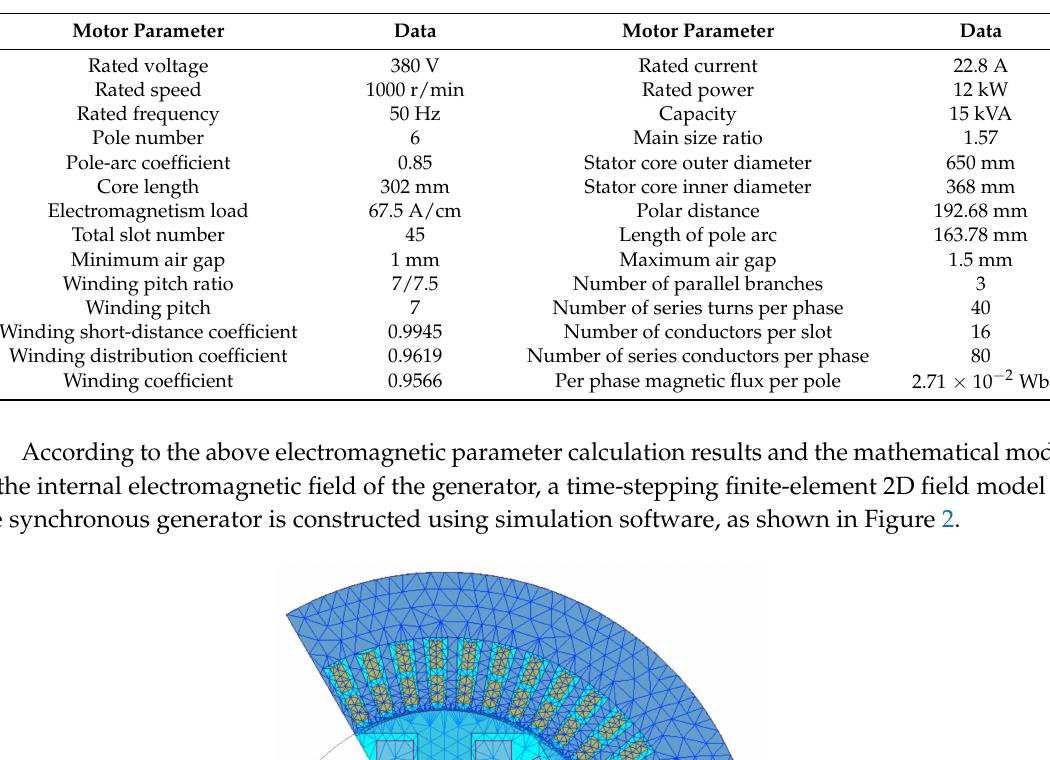
Table 1. Generator parameters.